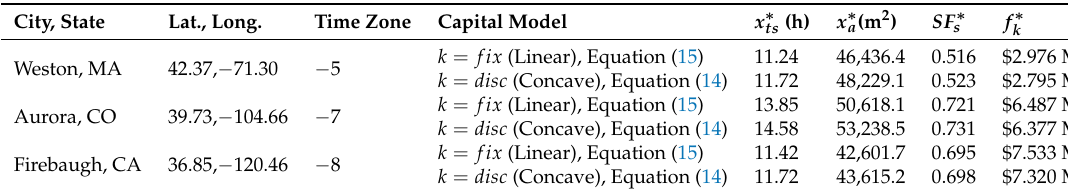
Table 1. The optimal solar-IPH hybridization strategies for the three geographic locations for constant IPH demand with ¯ q p = 10 5 kW th for the commercial fuel rate. The global optimal results for the concave capital cost model in Equation (14) are included for comparison against the linear capital cost model in Equation (15).